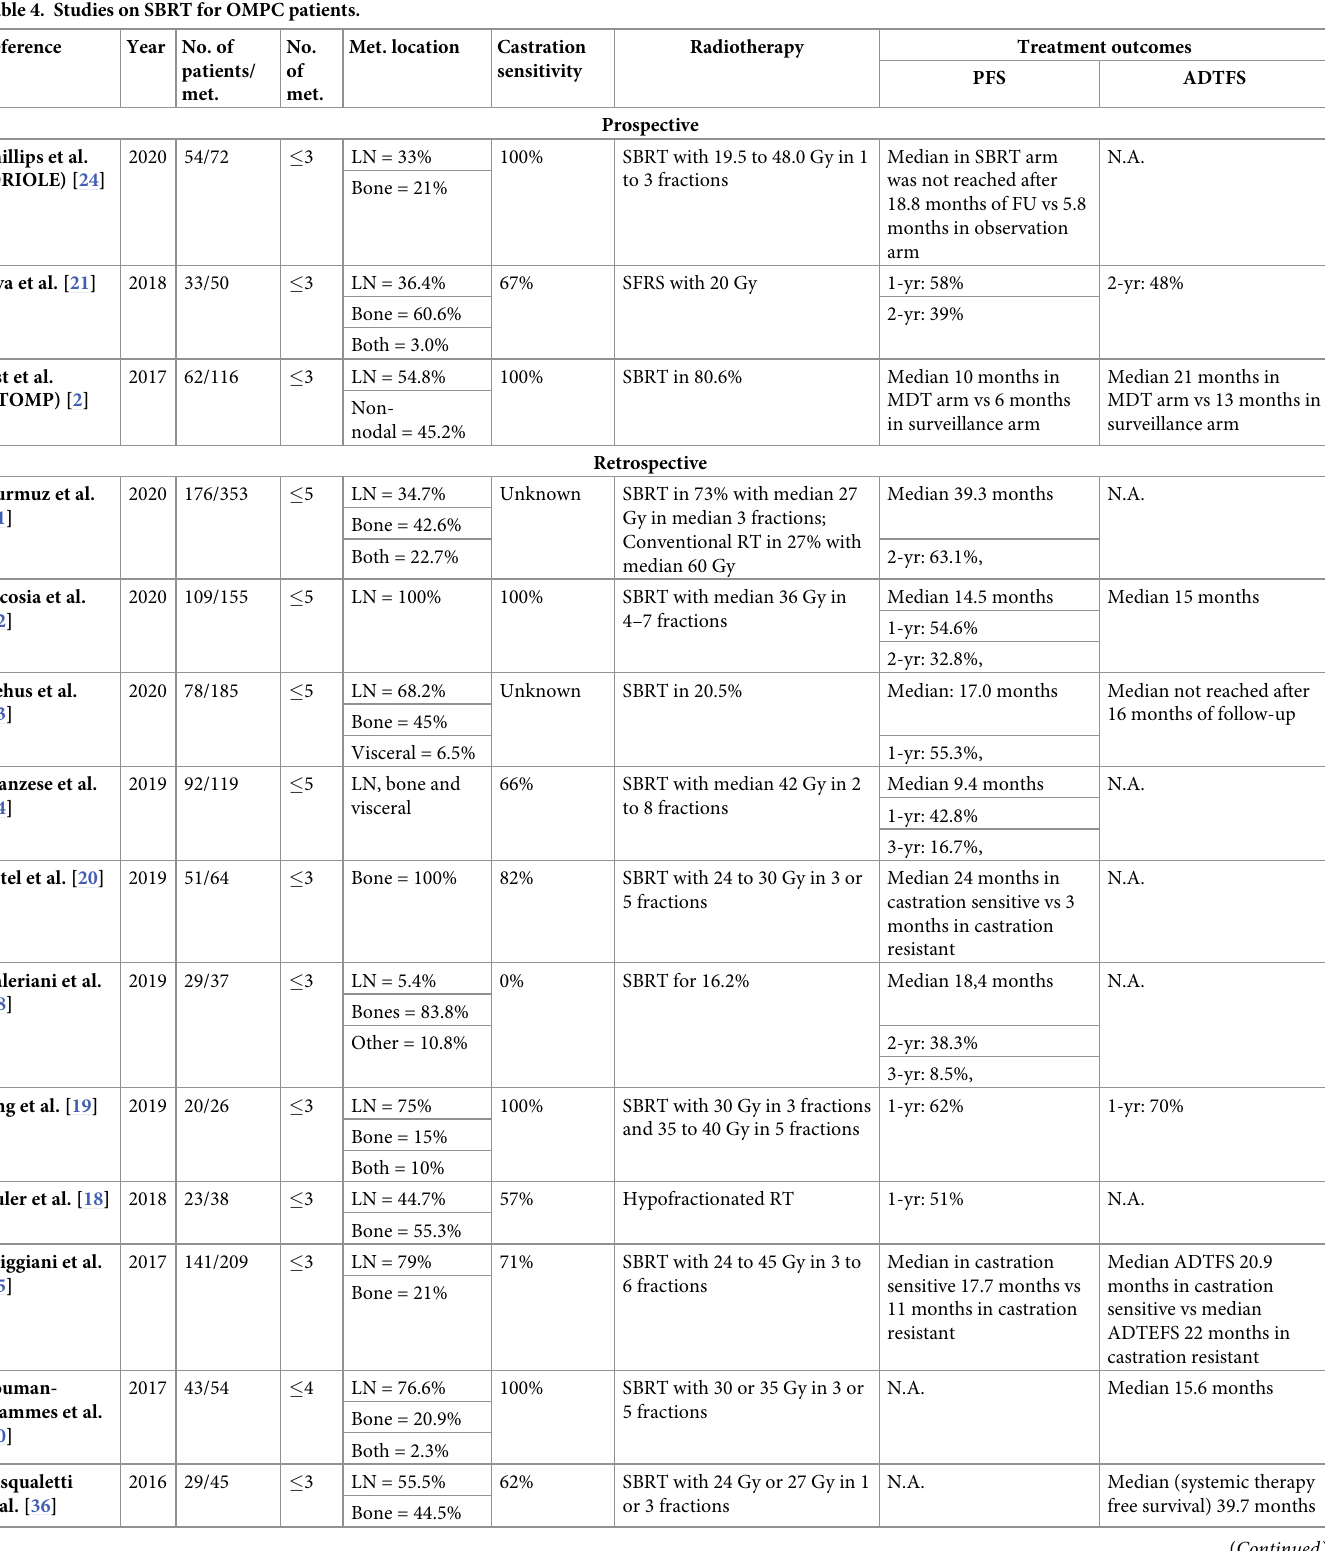
Table 4. Studies on SBRT for OMPC